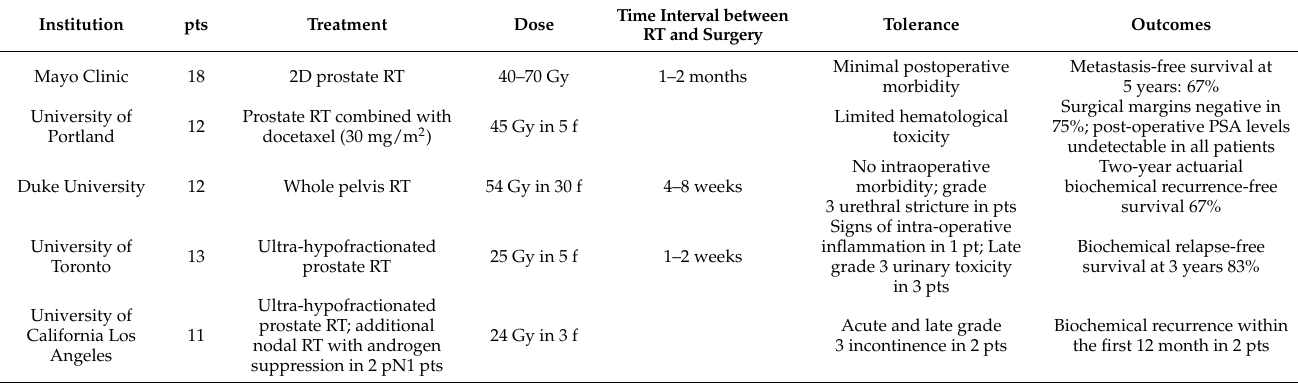
Table 2. Summary of pre-operative radiotherapy studies in locally advanced and high-risk prostate cancer patients. RT: radiotherapy; f: fractions; pts: